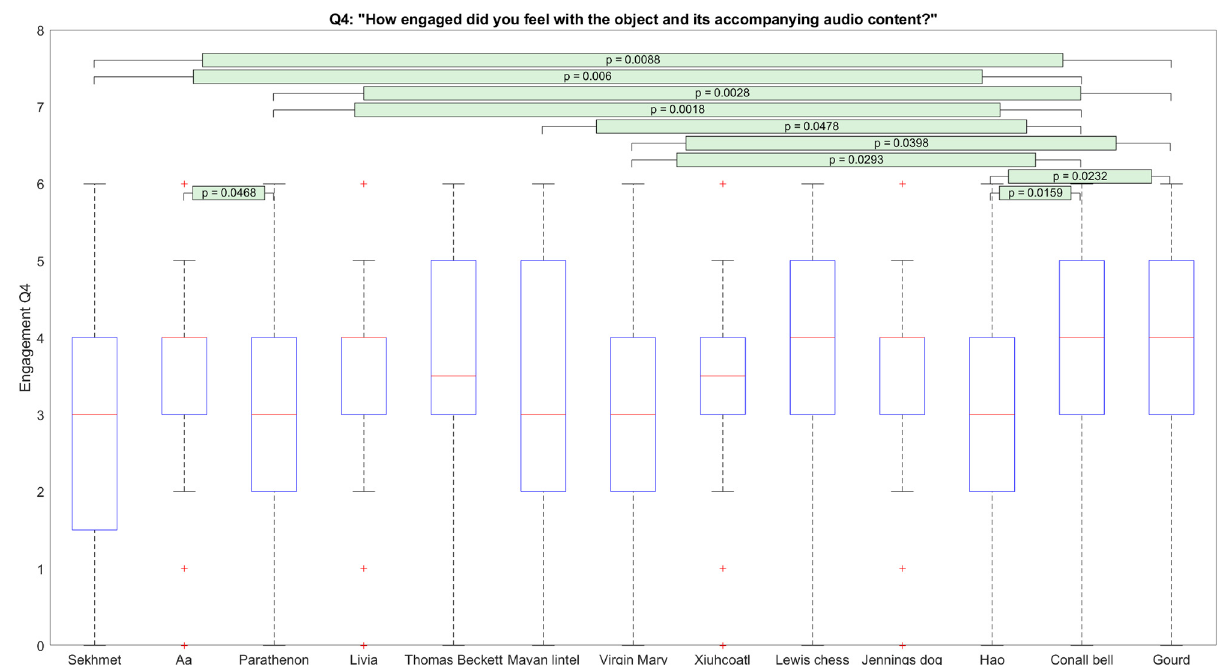
Fig 3. Distributions of answers given by participants to engagement question